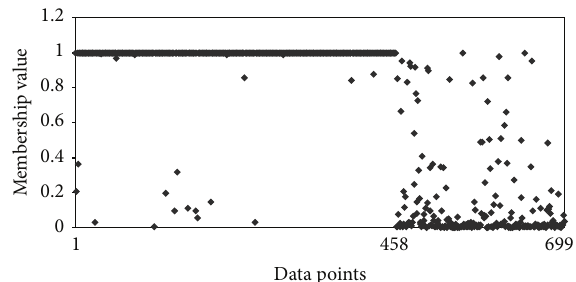
Figure 2: Membership for different data points for the benign cluster by using the Hamming distance for 𝑚 = 1.1 . The first 458 data points are benign and next 241 data points are malignant.